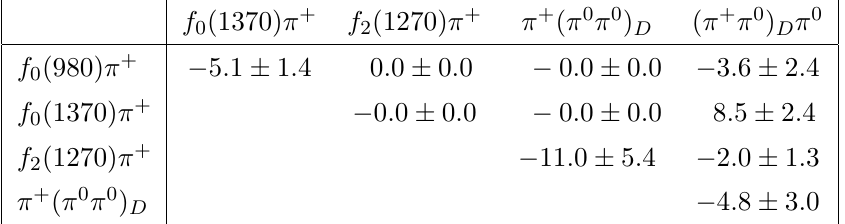
Table 4 . Interference fraction (%) between amplitudes where uncertainties are statistical